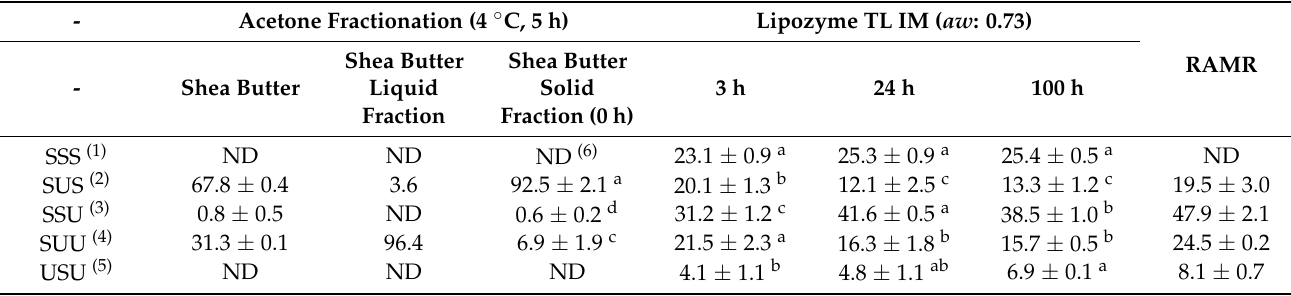
Table 1. Positional triacylglycerol (TAG) comparison (area%) of fractionations (liquid and solid) of shea butter, acyl migration reactants of shea butter solid prepared from different reaction times (0, 3, 24, and 100 h), and refined acyl migration reactant